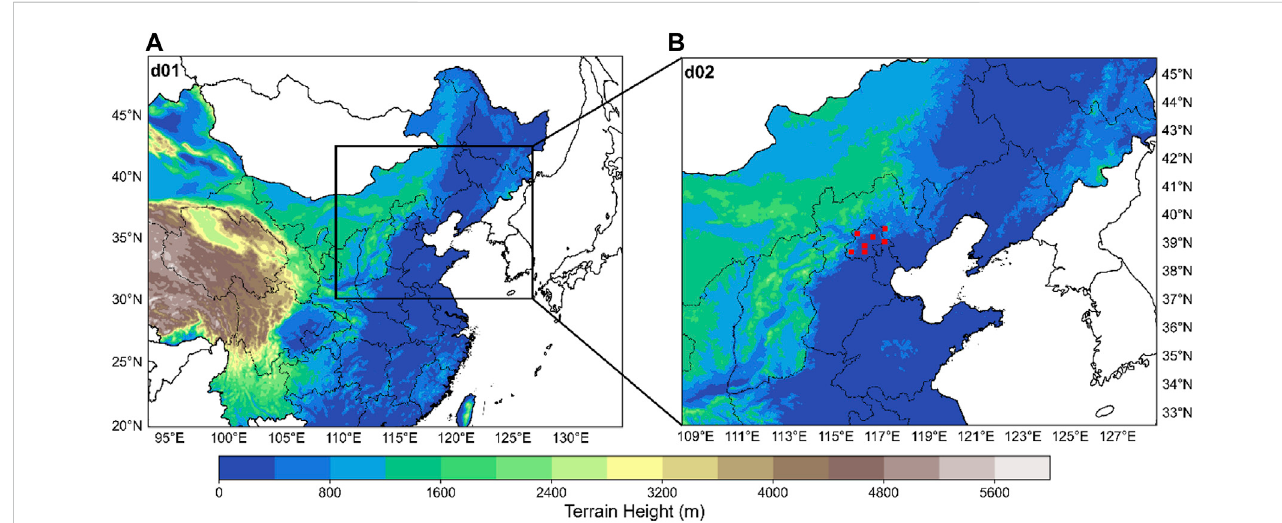
FIGURE 6 (A) The WRF model domain. Domain 2 (d02) is outlined by the black box. (B) Map of MWRs (red dots) located in d02. The colour shading represents